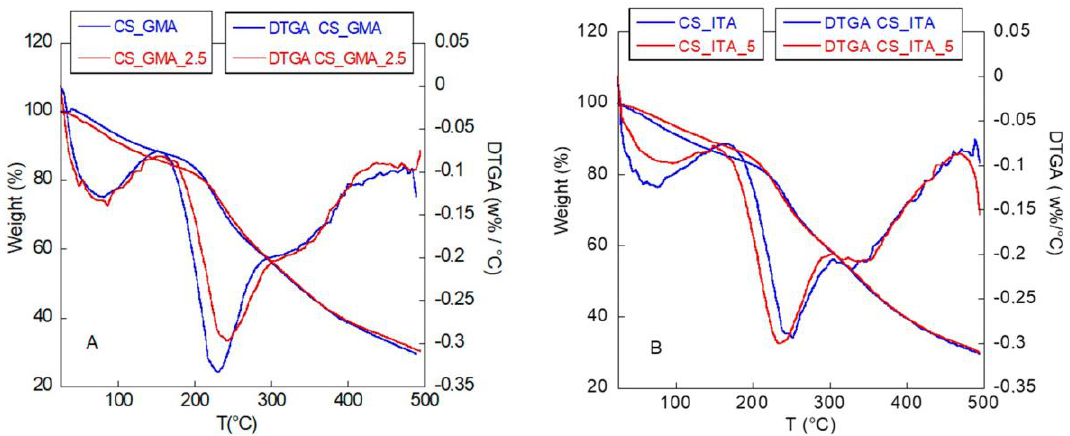
Figure 7. TGA and DTGA thermograms of CS_GMA ( A ) and CS_ITA ( B ) MIPs and NIPs.